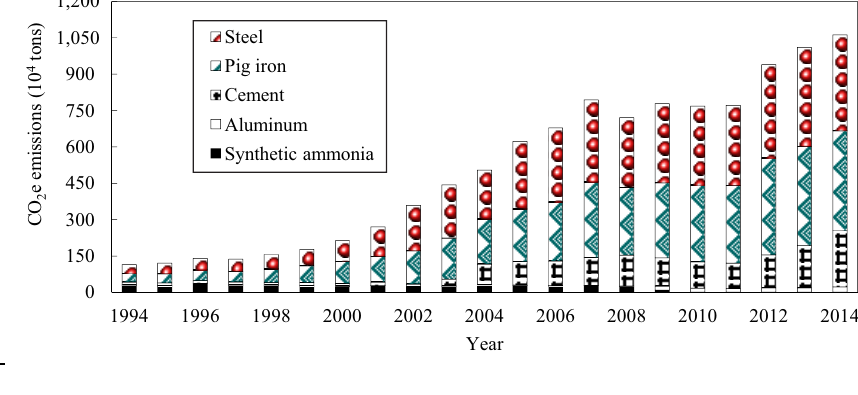
Figure 7. CO 2 e emissions from the industrial process